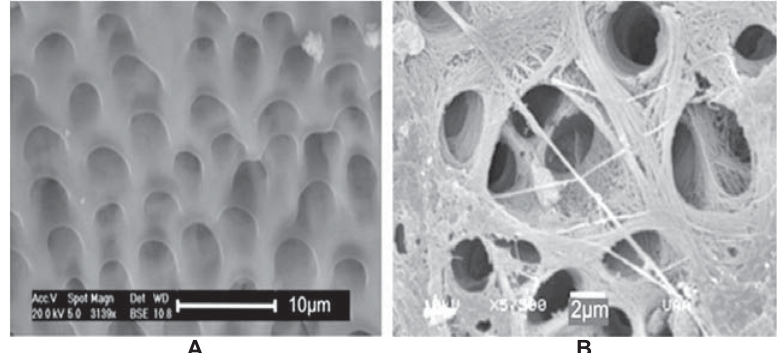
Figure 2B. Table 1 shows the means and standard deviations of the WCAs of the dentin surfaces in the non-silanized and silanized groups. The contact